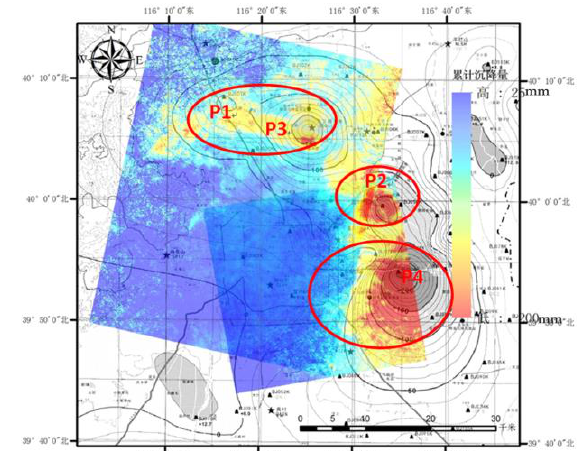
Figure 10. Insar monitoring result and contour of